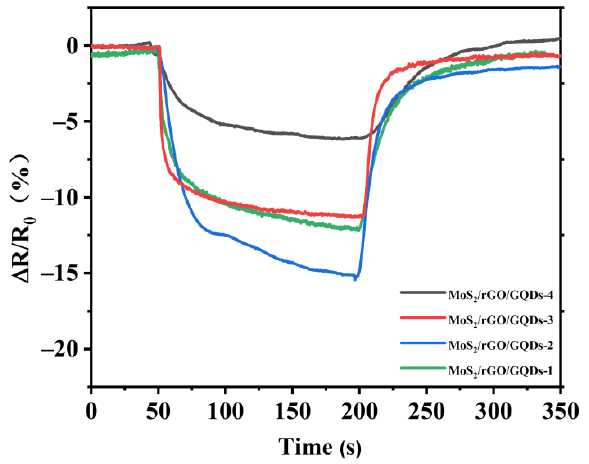
Figure 9. Response and recovery curves of MoS 2 /rGO/GQDs-based sensors exposed to 5 ppm NO 2 .